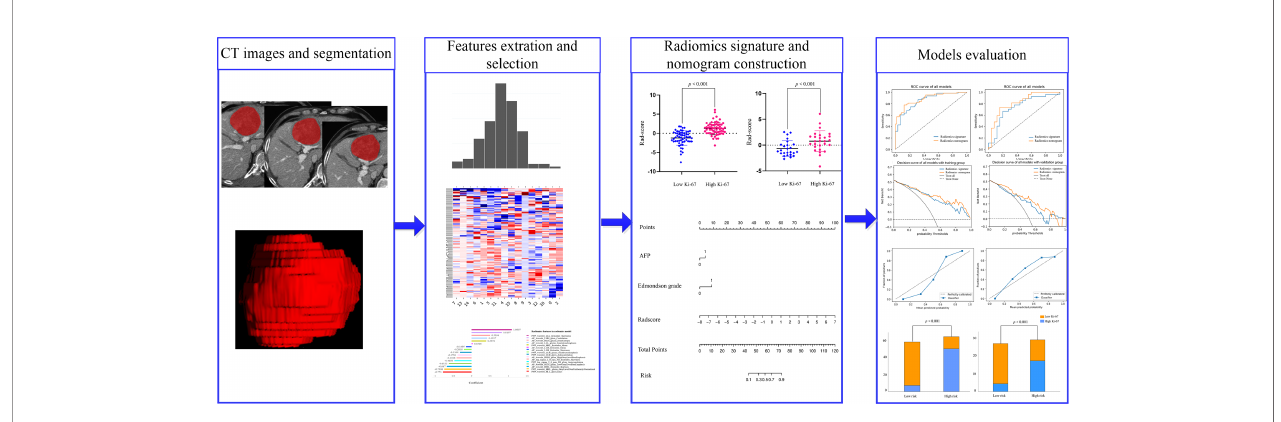
FIGURE 1 | Flowchart for the construction and evaluation of